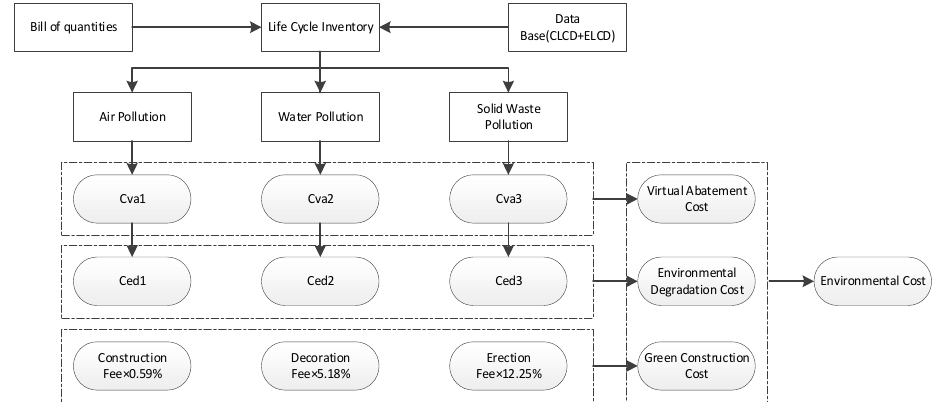
Figure 1. The flowchart of the model.